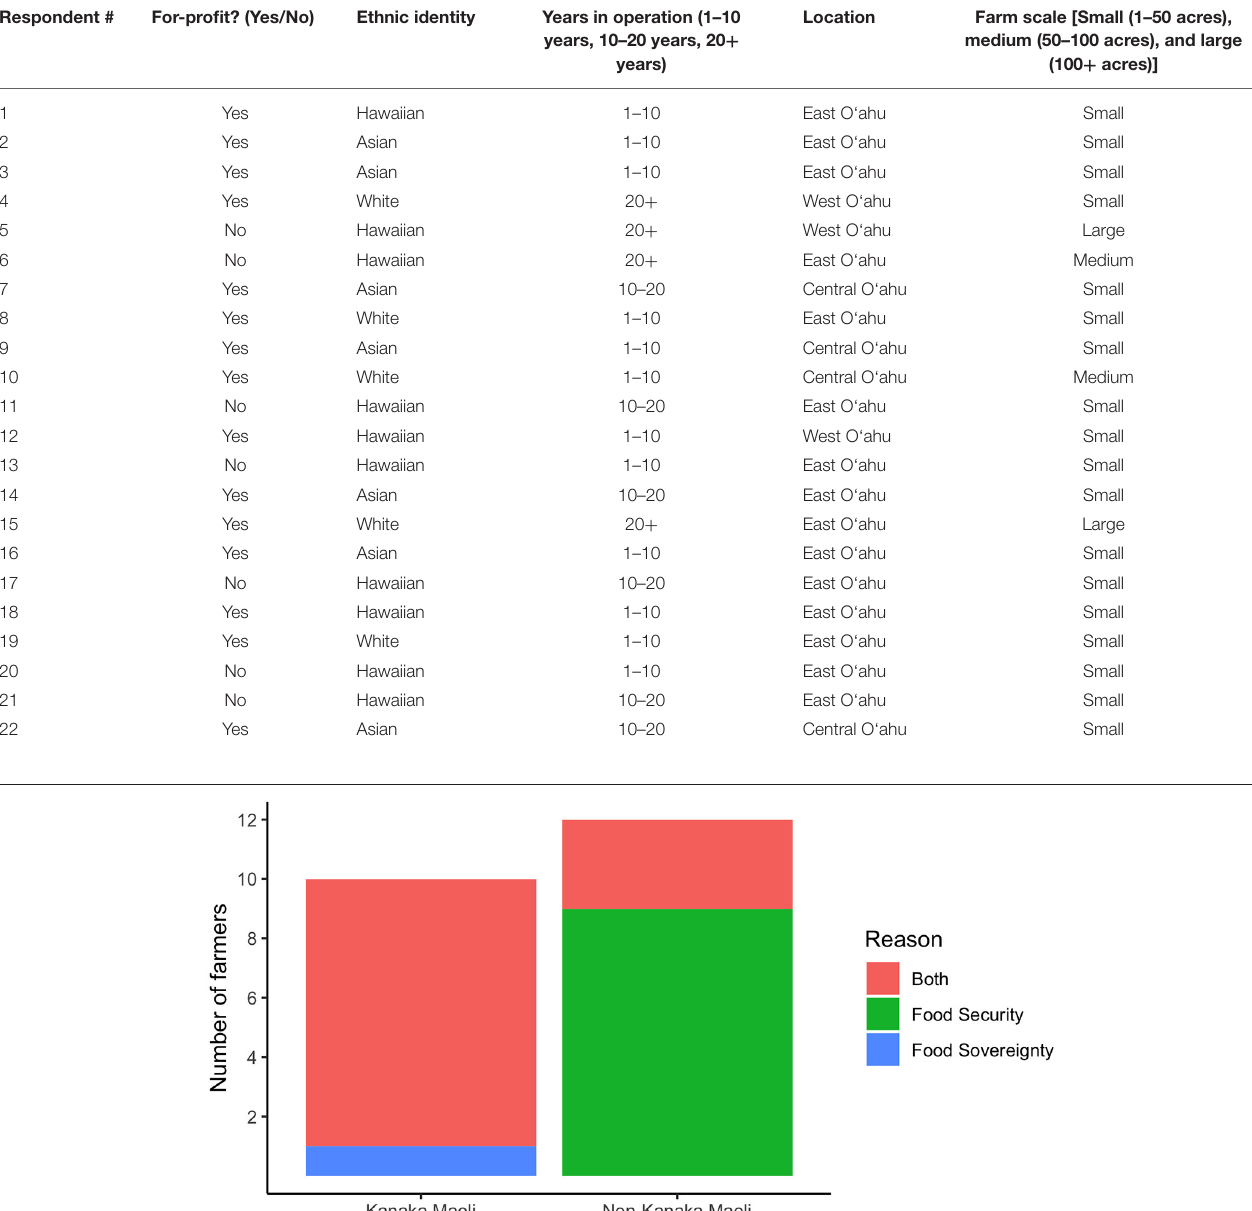
TABLE 1 | Demographic attributes of interviewed farmers (respondents).